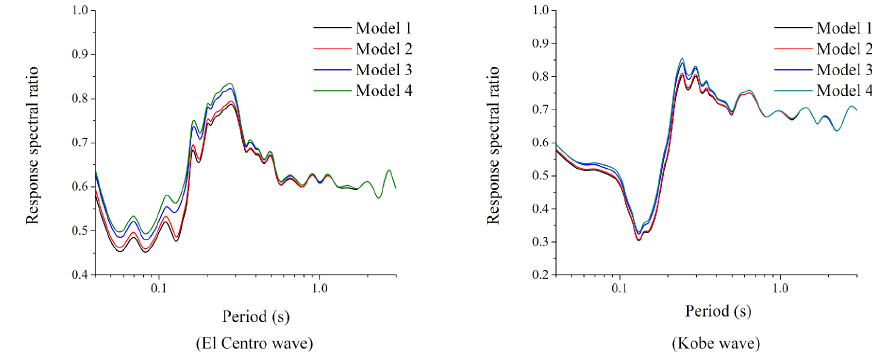
Figure 6. Response spectral ratio between the surface and the base input of a P-wave